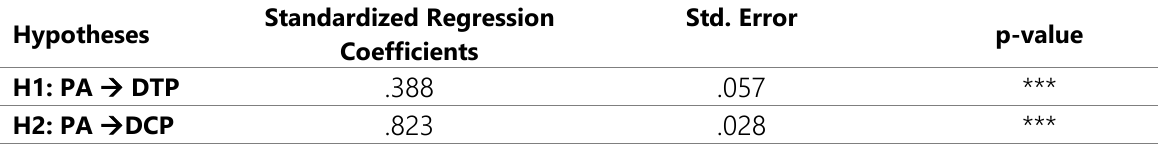
Table 3: Coefficients value for Structural